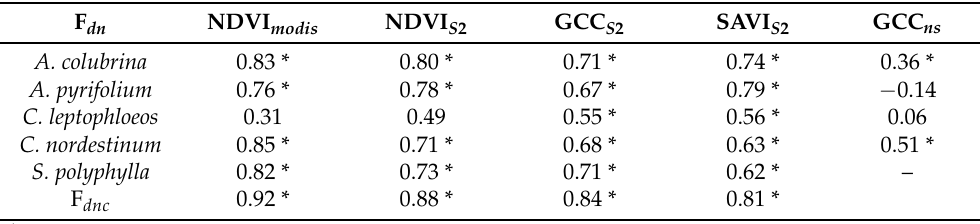
Table 4. Pearson correlation coefficient between F dn and NDVI modis , NDVI S 2 , GCC S 2 , SAVI S 2 and